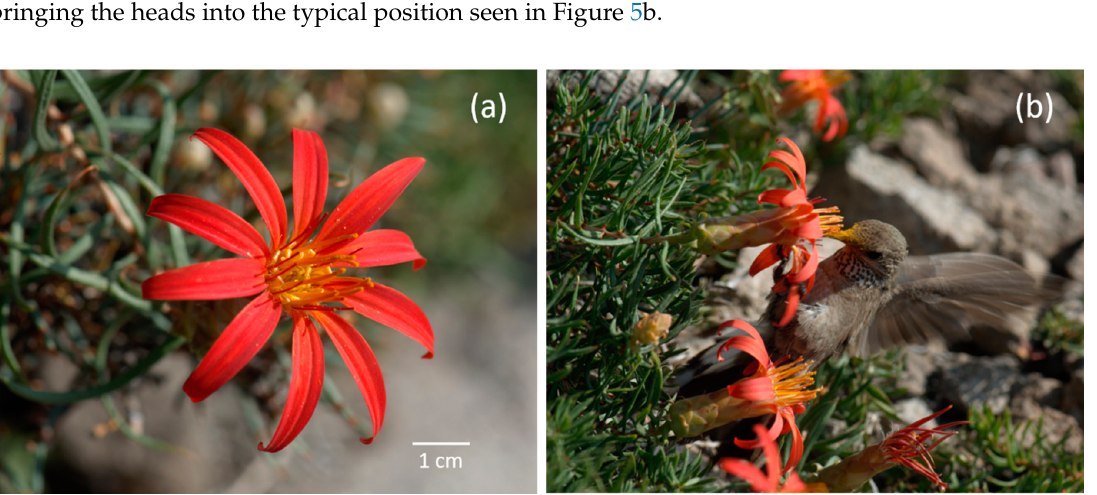
Figure 4. Potential floral longevity in M. subulata . ( a ) Duration of the male, neutral (stigmas emerging, not bifurcate), receptive stigma and dry stigma stages of individual florets (Mean + SE, N = 25). ( b ) Total longevity of pollinator-excluded flowers-heads (Mean + SE, N = 15) showing the duration of different stages.